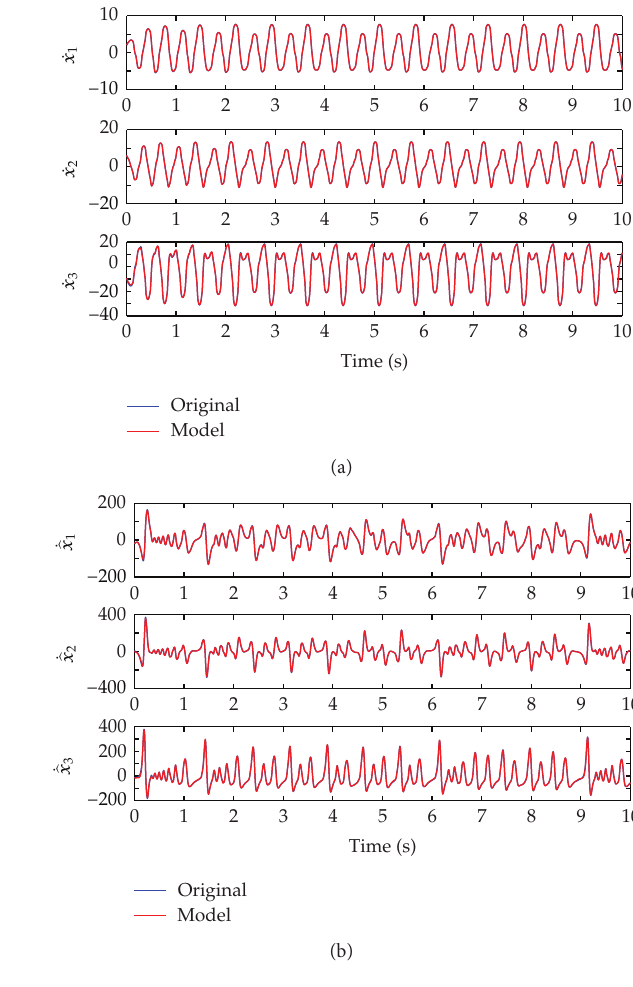
Figure 3: (a) The responses of model. (b) The responses of